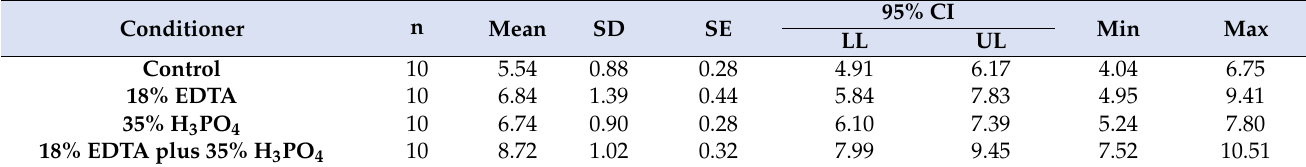
Table 1. Descriptive values of adhesive strength (MPa) according to type of conditioner used.